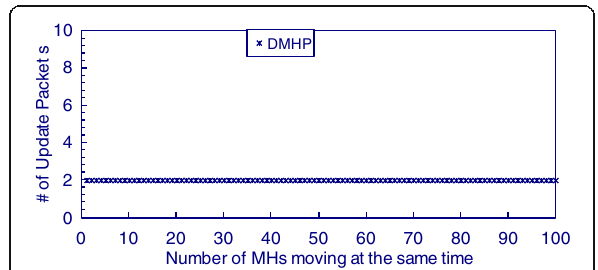
Fig. 17 Signaling overhead of DMHP for managing handover of many MHs at the same time to the same N-PoA but all coming from the same PoA using